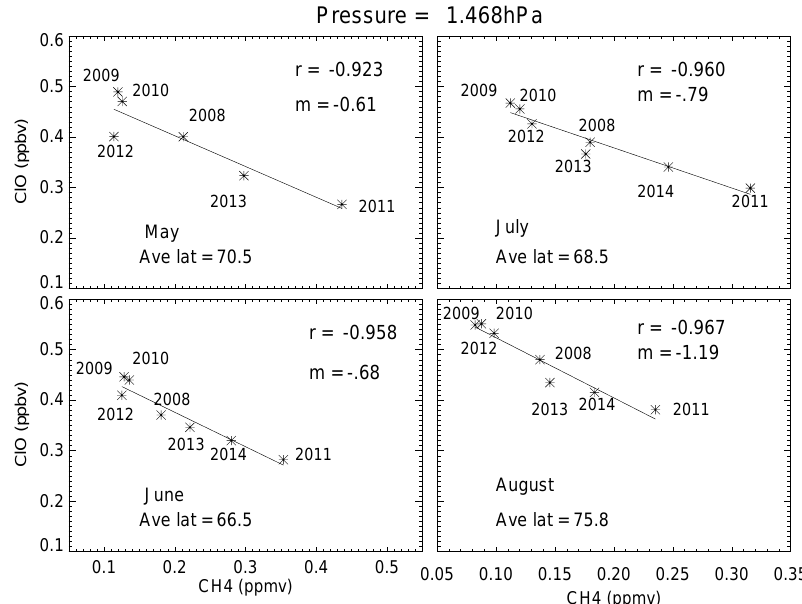
Figure 3. Scatter plot of zonal mean, monthly averaged MLS ClO vs. SOFIE CH 4 at 1.47hPa. The MLS data are sampled at the SOFIE occultation latitude, the monthly averages of which are indicated in each panel. In the upper right of each panel the linear correlation coefficients ( r ) between each dataset for each month are given, as well as the slope of the linear fit ( m ) in units ofppbv of ClO per ppmv of CH 4